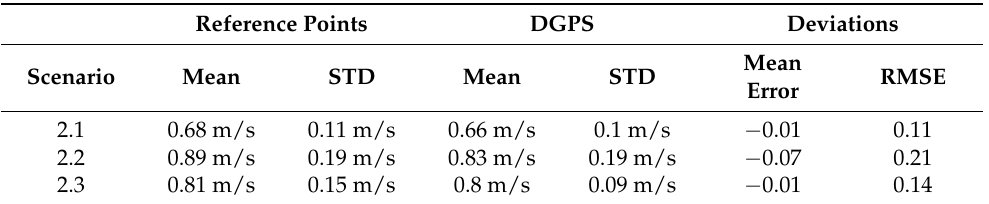
Table 5. Comparison of vertical approach speed between Reference Points approach and DGPS measurements using berthing scenarios (Scenarios 2.1–2.3).